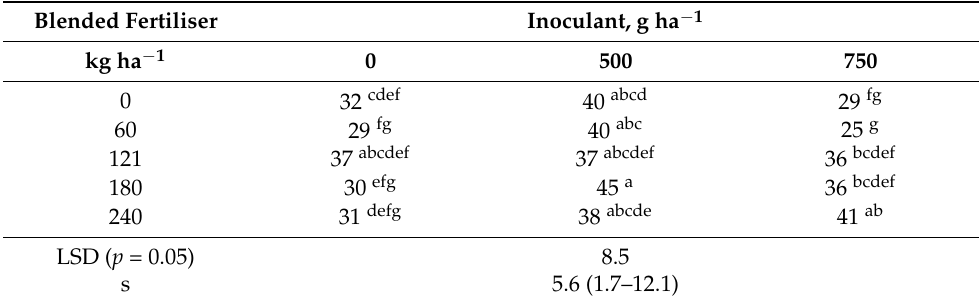
Table 11. Harvest index as affected by combining blended fertiliser and inoculant. Blended